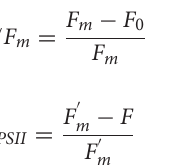
(PAR) meter (Apogee SQ-500) to ensure the same PAR